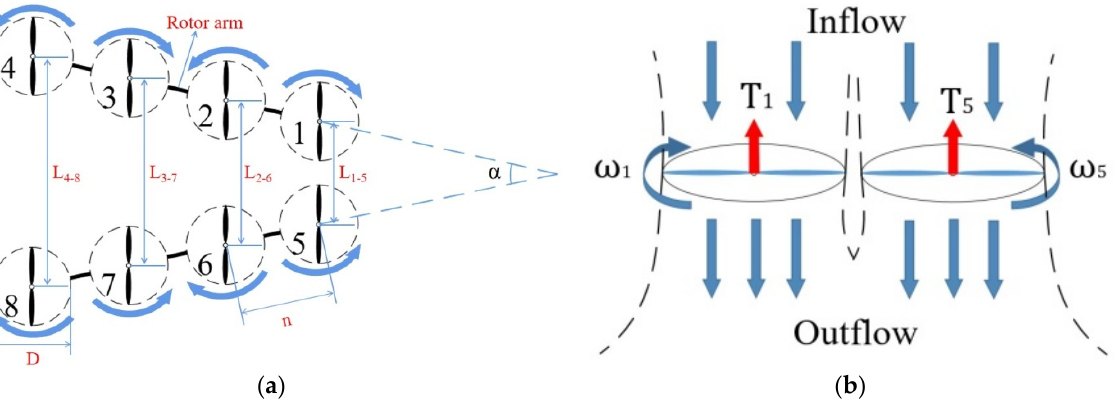
Figure 2. Sketch of V8 Octorotor MAV. ( a ) Geometry and forces which each rotor is labelled from 1 to 8, and arrows are the rotation direction which means adjacent rotors are clockwise and counterclockwise.; ( b ) Flow field with aerodynamic interference for rotors 1 and 5, for instance.